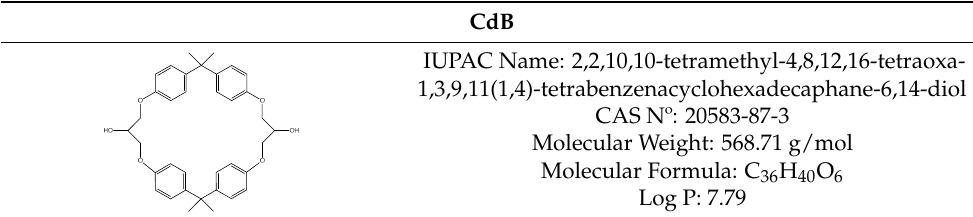
S.A., Madrid, Spain). To carry out the solid phase extraction (SPE), Sep-Pak C18 cartridges were obtained from Waters (Ireland). The chemical structure and some physico-chemical Table 1. Chemical structure and physical-chemical properties of CdB. Table 1. Chemical structure and physical-chemical properties of CdB